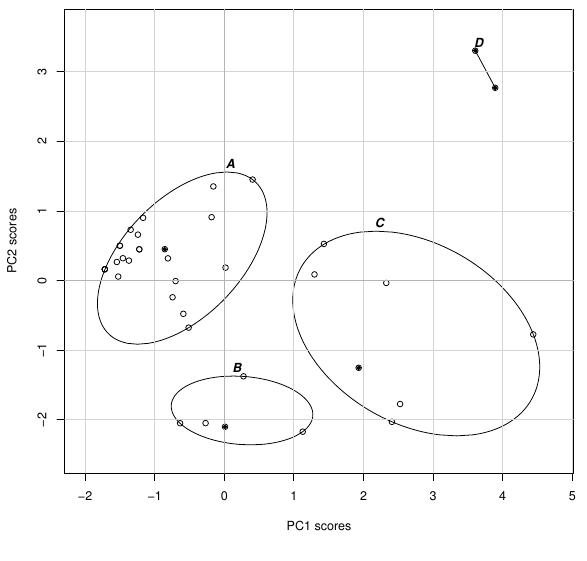
Figure 4 A four cluster grouping of the user profiles . Circles indicate individual user profiles as in Figure 3, ellipses the clusters. Full circles indicate for each cluster the subject clos- est to the average user profile within the group. See also Table